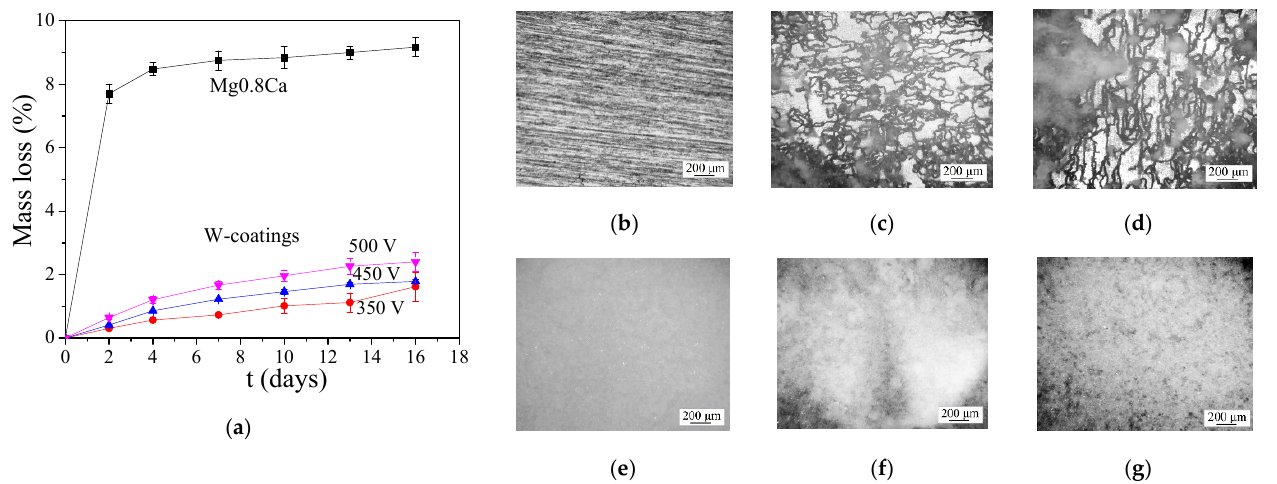
Figure 10. Graphs of the mass loss over time ( a ); optical images of the bare Mg0.8Ca alloy ( b – d ) and of the W-coating deposited at the voltage 500 V ( e – g ); ( b , e )—initial samples, ( c , f )—after 7-day dissolution, ( d , g )—after 16-day dissolution in 0.9% NaCl.